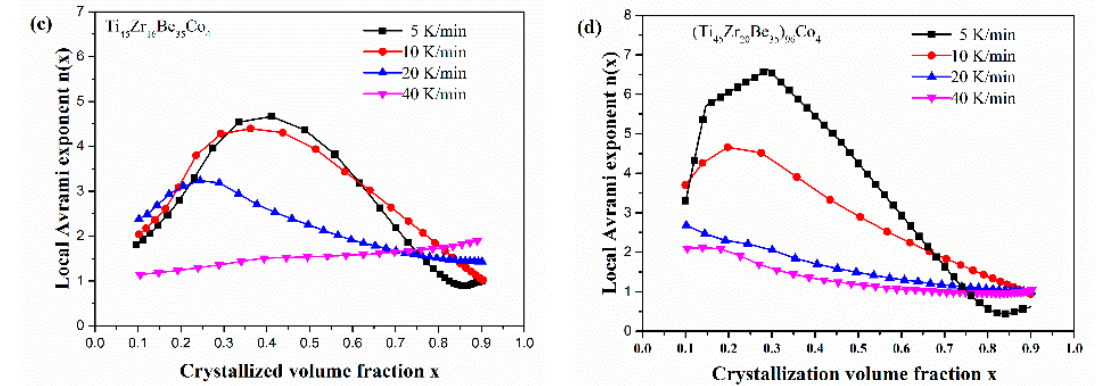
Figure 14. n ( x ) as a function of x for ( a ) Ti 45 Zr 20 Be 35 , ( b ) Ti 45 Zr 20 Be 31 Co 4 , ( c ) Ti 45 Zr 16 Be 35 Co 4 , and ( d ) (Ti 45 Zr 20 Be 35 ) 96 Co 4 BMGs (0.1 ≤ x ≤ 0.9).